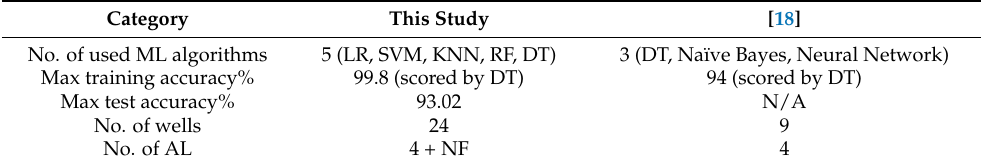
Table 3. AL selection results in comparison to a recent study using ML.